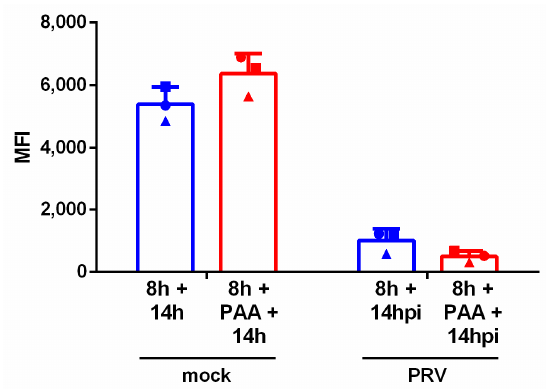
Figure 3. Viral late gene expression is not required for PRV-induced downregulation of NKG2D ligand expression. SK cells were cultivated in suspension for 8 h before mock or PRV infection. SK cells were treated or untreated with phosphonoacetic acid (PAA, 400 µg/mL) starting 30 min before inoculation. All samples were incubated with recombinant Fc-tagged human NKG2D protein at 14 hpi and analyzed using flow cytometry. Graph shows the median fluorescence intensity (MFI) for each condition. Bars represent the mean value ± SD; different symbols correspond to individual data points from different independent experiments, n = 3.